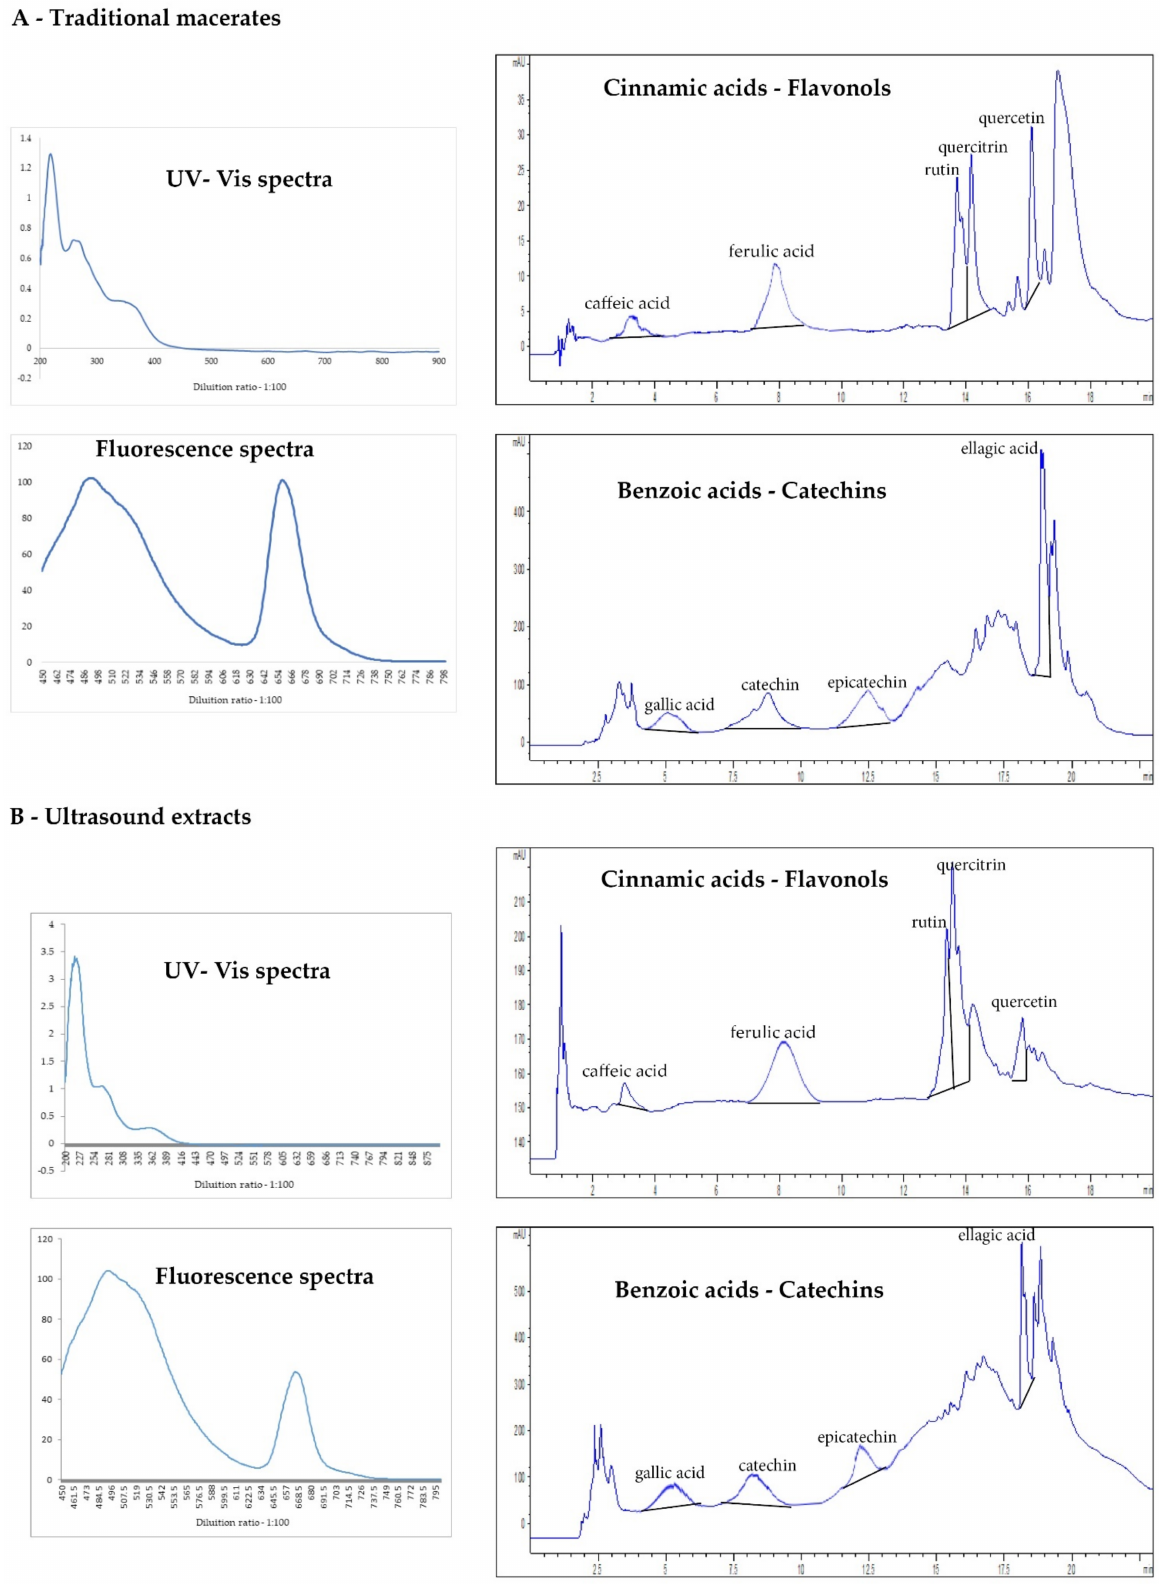
Figure 3. The chromatographic pattern and spectroscopic data of the analysed extracts: ( A ) traditional macerates and ( B ) ultrasound